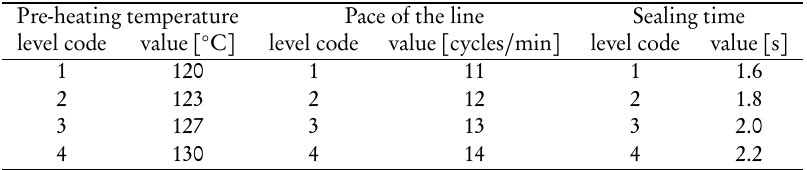
Levels of control factors selected for the experimental